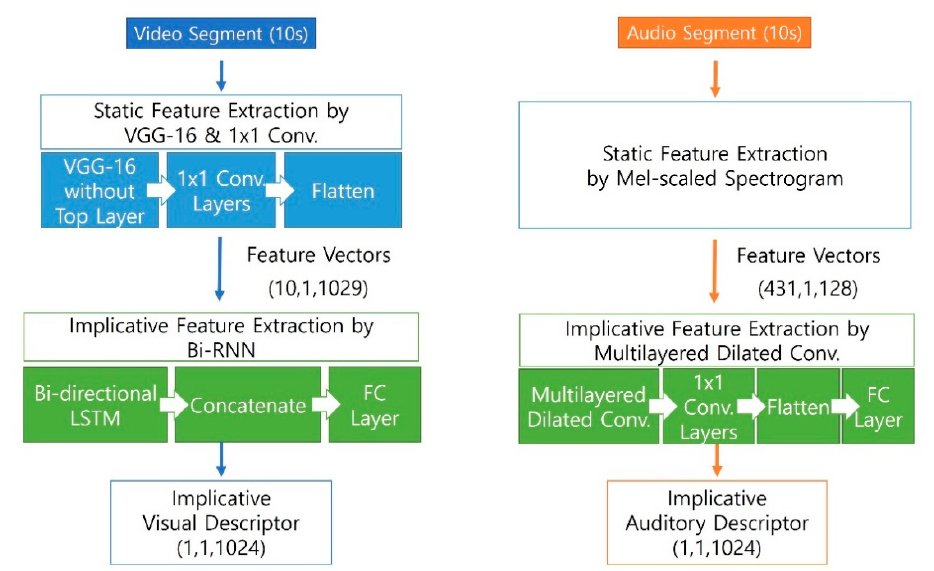
Figure 2. Implicative feature extraction procedure from the video and audio segments.